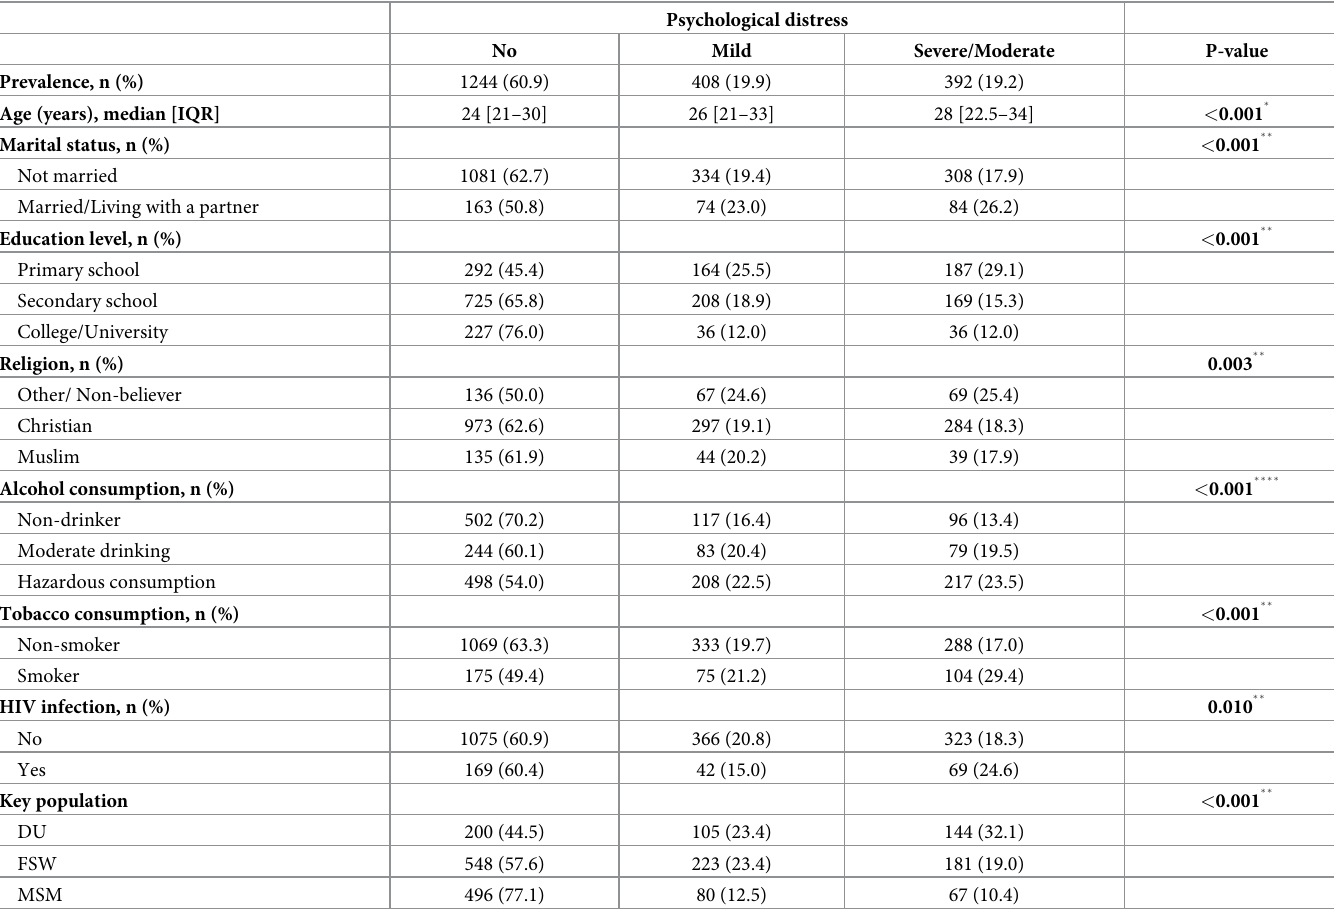
Table 2. Associations between psychological distress a and sociodemographic and clinical characteristics among key populations (N = 2044).